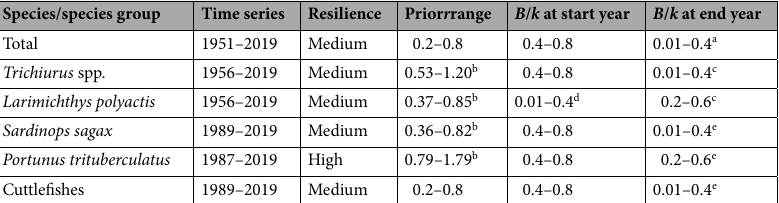
Species/species group